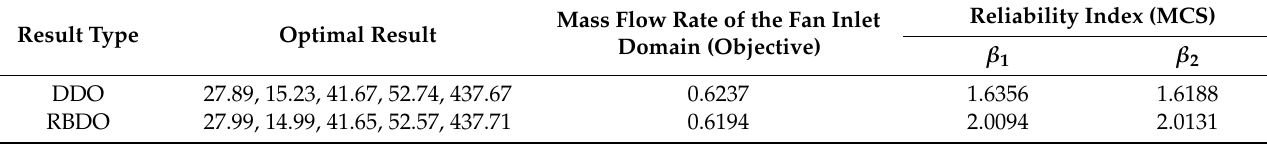
Table 10. Results comparison of DDO and RBDO.